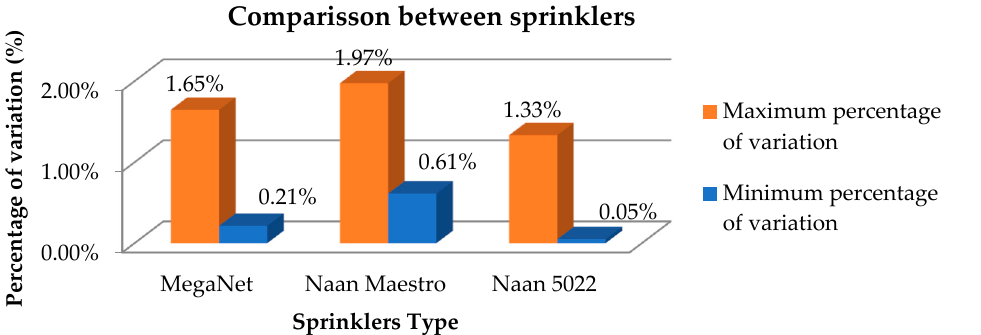
Figure 7. Comparison between sprinklers according to the percentage variation of the coefficients obtained.